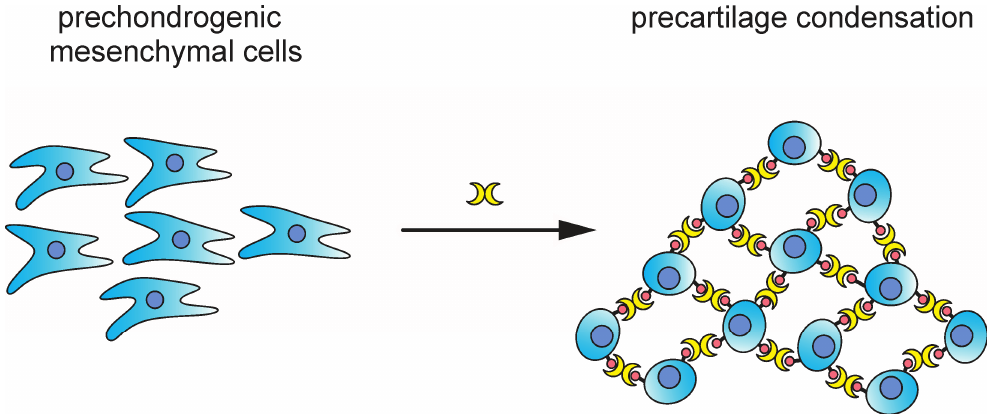
Figure 11. Illustration of the assumed role of homodimeric CG-1A to bridge precartilage mesenchymal cells. This CG targets specific glycoconjugates, which can be considered